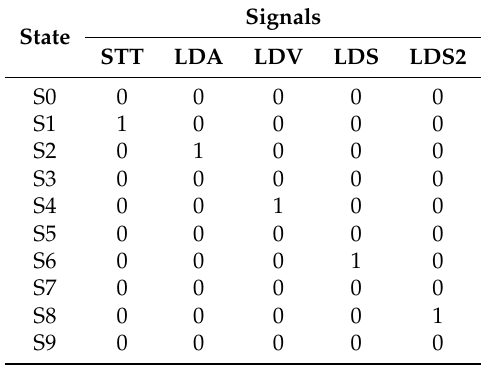
Table A1. State machine signals of the discrete parabolic profile.